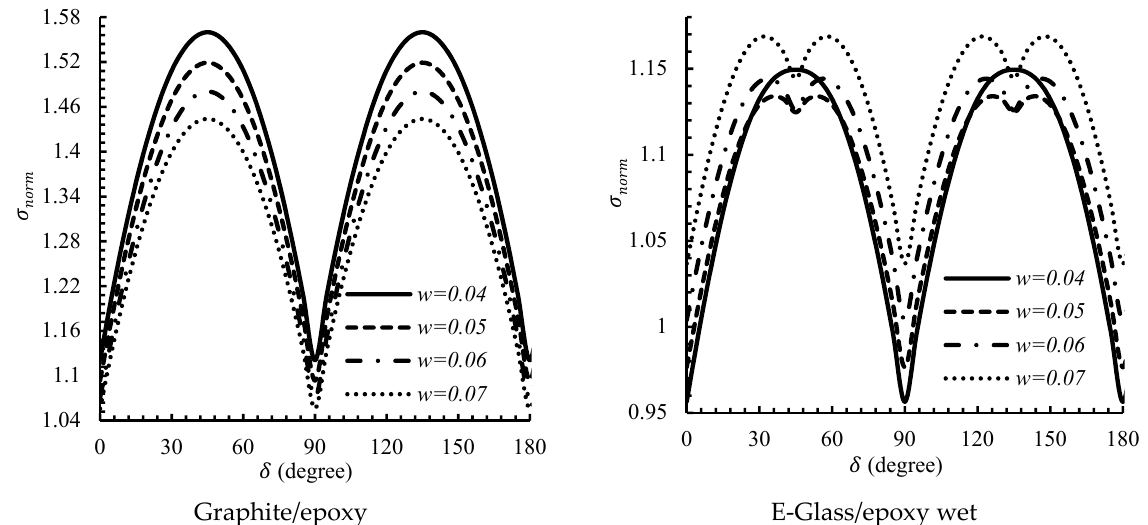
Figure 9. Effect of heat flux angle on the maximum normalized stress in different values of w.